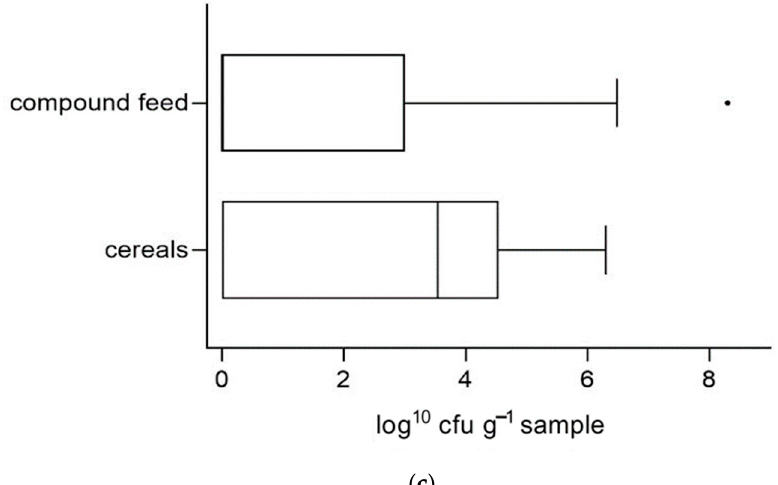
Figure 3. ( a ) Distribution of aerobic germ counts (log 10 cfu g − 1 sample as fed) in grains and compound feedstuffs. ( b ) Distribution of mold counts (log 10 cfu g − 1 sample as fed) in grains and compound feedstuffs. ( c ) Distribution of yeast counts (log 10 cfu g − 1 sample as fed) in grains and compound feedstuffs.